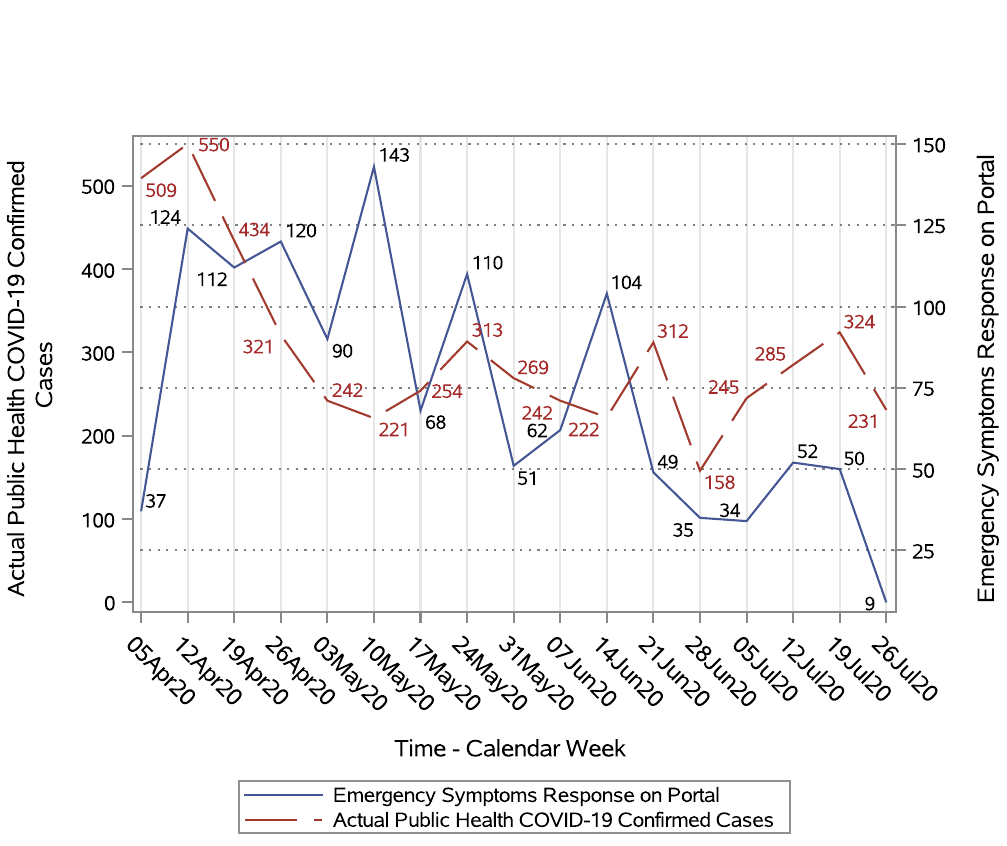
Figure 2. Trend in number of emergency COVID-19 symptoms on portal versus actual diagnosed COVID-19